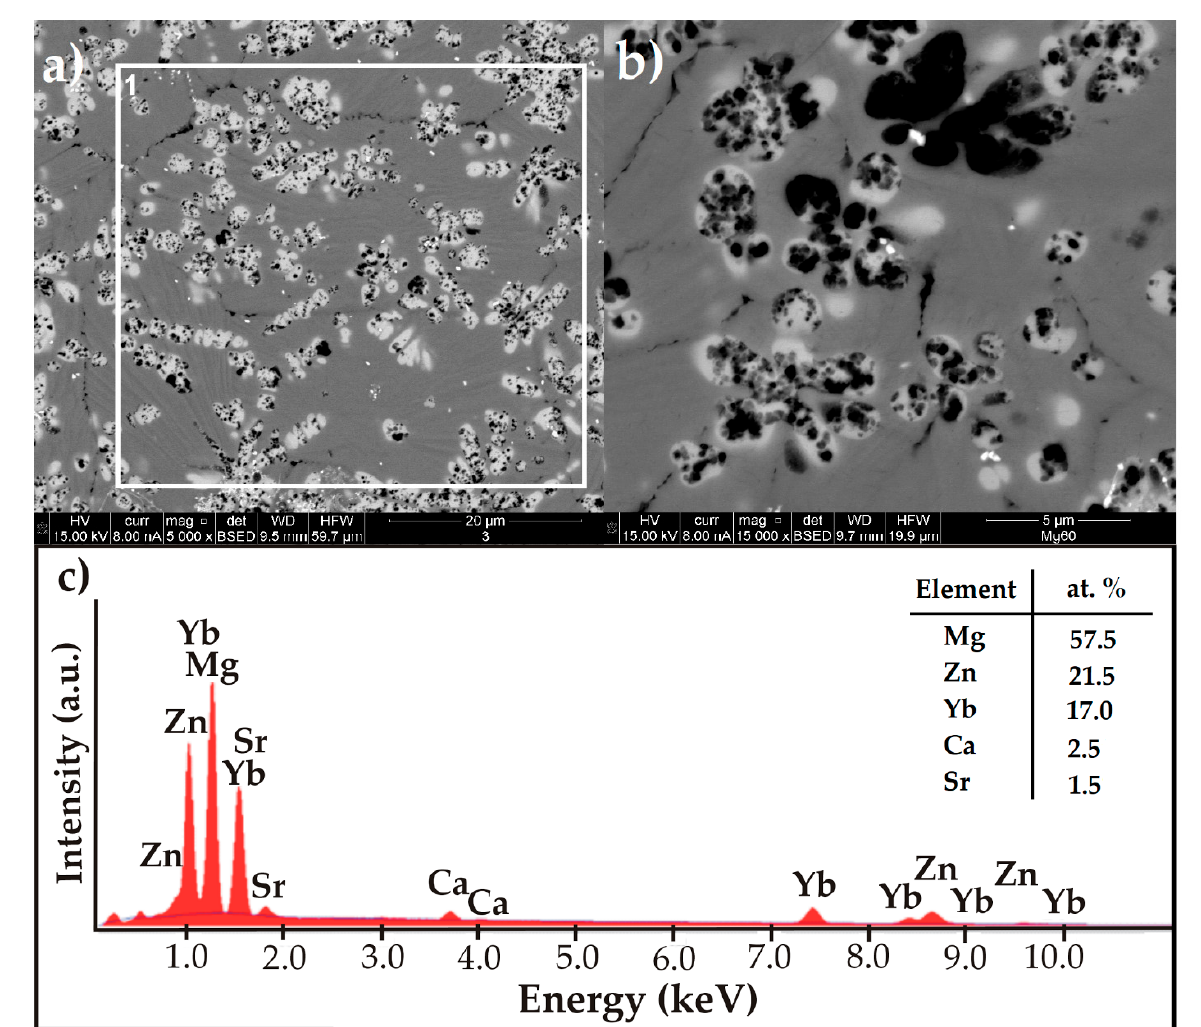
Figure 1. SEM-BSE image of Mg 60 Zn 20 Ca 2.6 Yb 15.7 Sr 1.7 alloy in a form of a plate ( a , b ) and EDX spectra ( c ) of the selected area (frame 1).